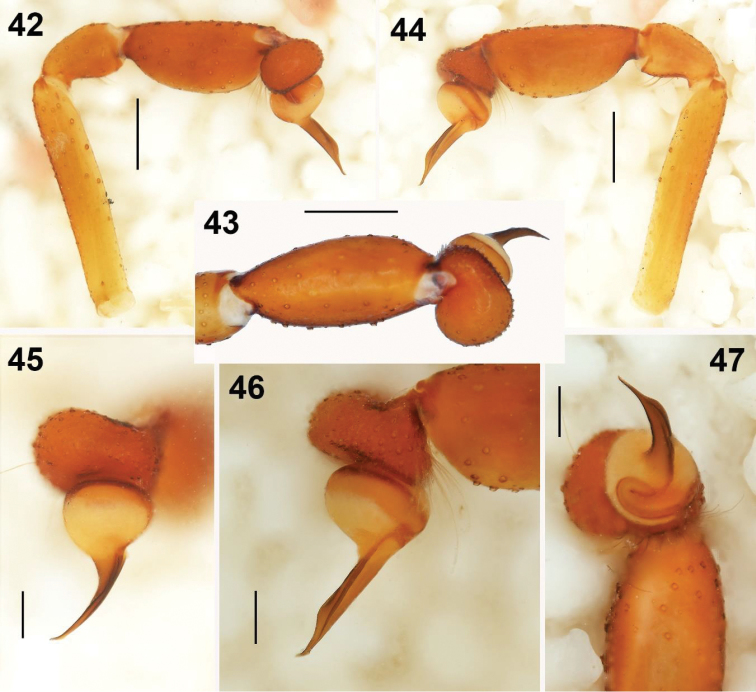
Male holotype (examined) of Loxosceles
misteca Gertsch, 1958 (AMNH_IZC 00327631), from Taxco, Municipality Taxco de Alarcón, Guerrero, Mexico; 1946, collected in the fall, Leo Isaacs leg. 42–44 left palp, prolateral, dorsal and retrolateral views respectively 45–47 detail of the bulb and embolus, dorsal, retrolateral and apical views, respectively. Scale bars: 0.5 mm (42–44), 0.2 mm (45–47).